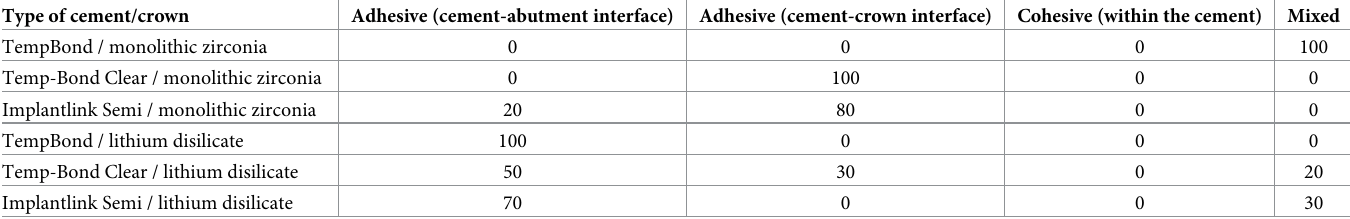
Table 7. Frequency of mode of failure in different groups (%).